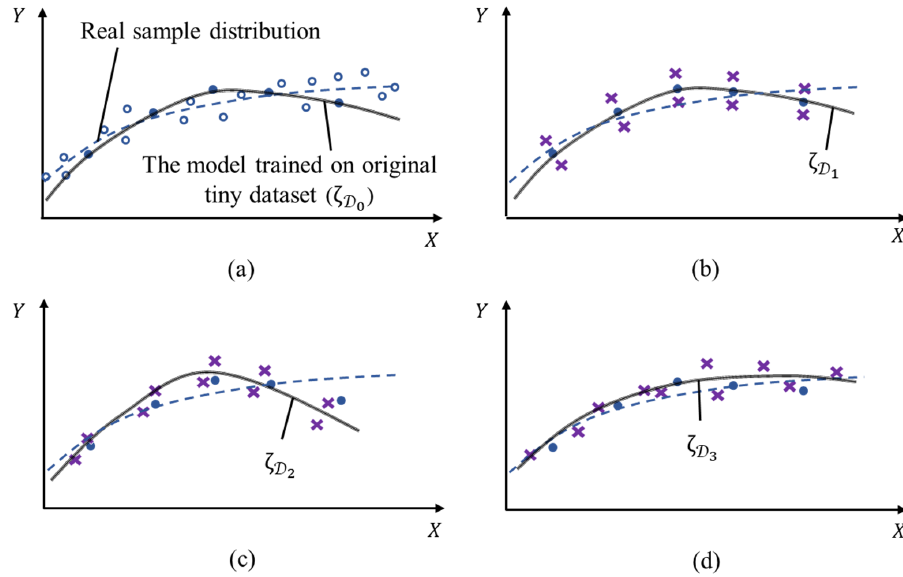
Figure 2. Schematic diagram of the effect of data augmentation on the trained models. ( a ) Comparison between real sample distribution and the model trained on the original small dataset. ( b – d ) Models